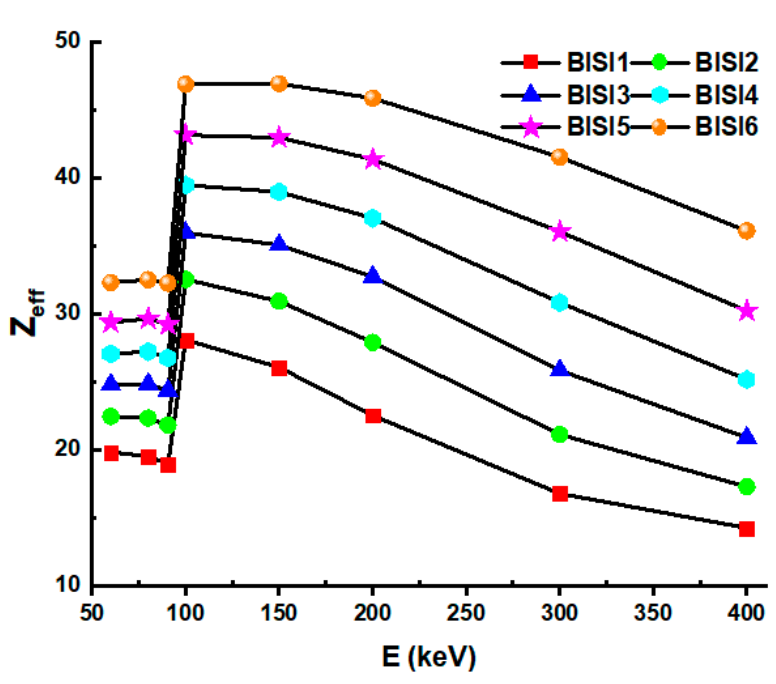
Figure 6. Mean free path (MFP) values as a function of photon energy of glass samples.